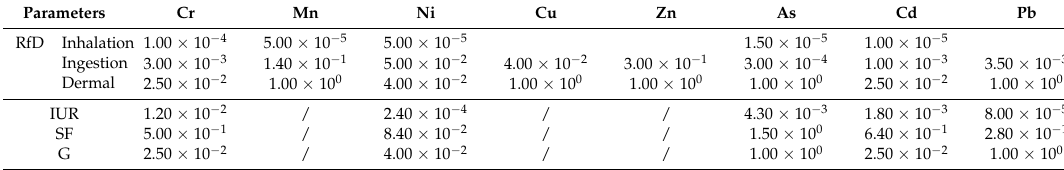
Table 2. The values of the reference dose (RfD; mg kg − 1 day − 1 ), inhalation unit risk (IUR; ( µ g m − 3 ) − 1 ), slope factor (SF; mg kg − 1 d − 1 ), and gastrointestinal absorption factor (G) for heavy metals [19,23,24,26]. Parameters Cr Mn Ni Cu RfD Inhalation 1.00 × 10 −